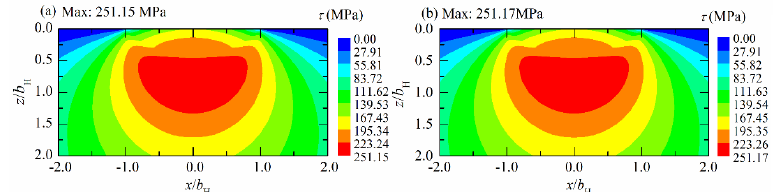
Figure 2. Comparison of the maximum shear stress of a half plane of the substrate material subjected to surface contact loading, ( a ) the exact analytical solution given by McEwen, ( b ) the solution of the present method. Table 2. Input parameters of the present method for simulating the multilayered solid with 40 layers subjected to surface contact loading.